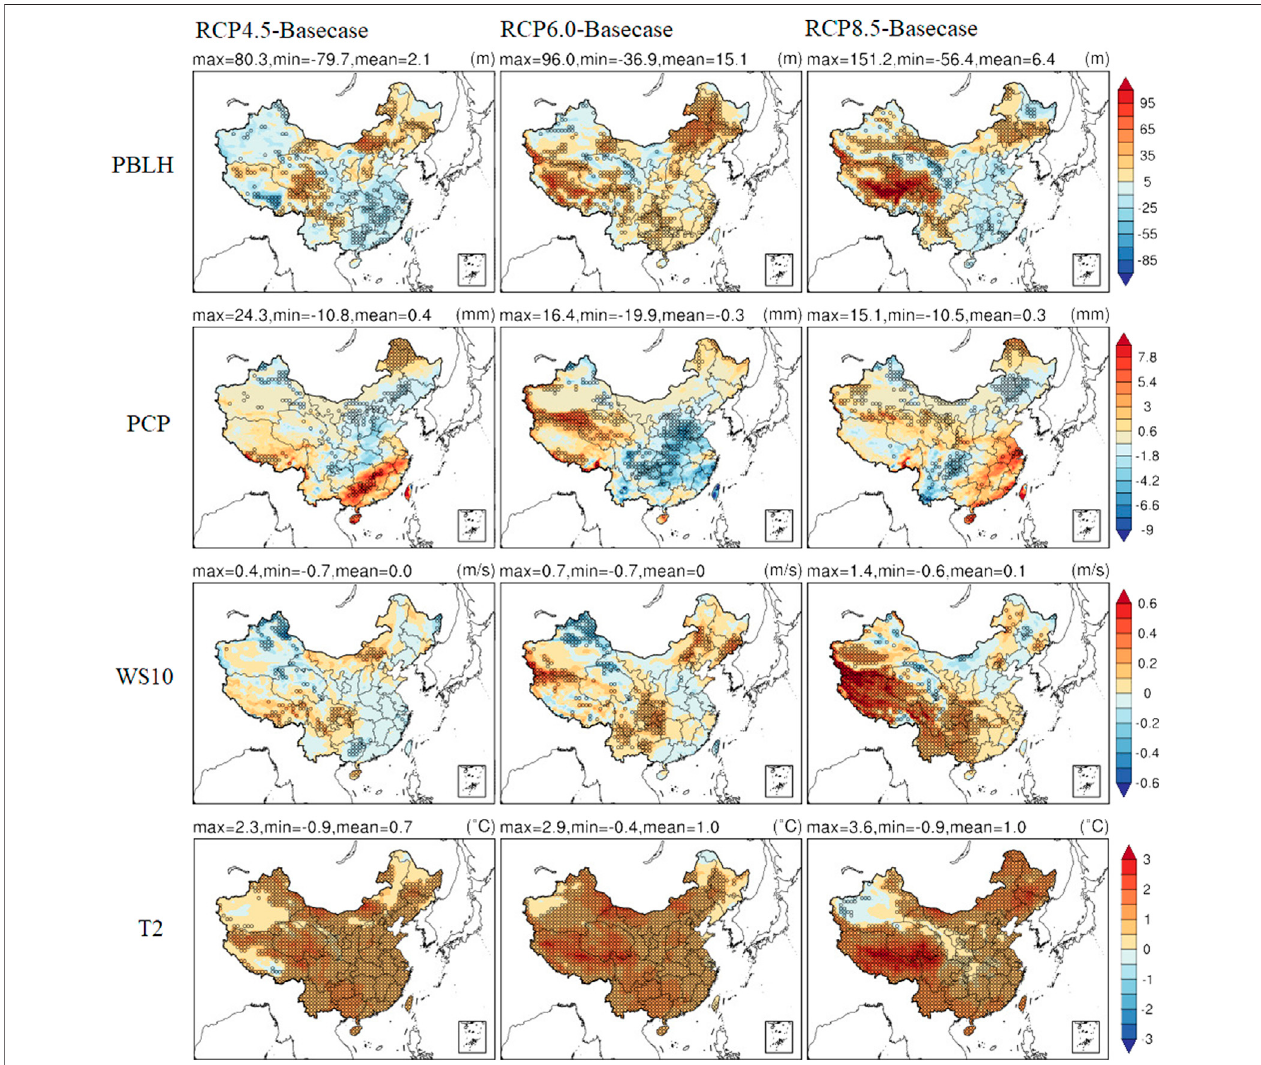
FIGURE 3 | Spatial distributions of the projected changes in meteorological fi elds for the 2046 – 2055 period relative to the 2006 – 2015 period. Signi fi cant changes (con fi dence level of 95%) are marked with circles.